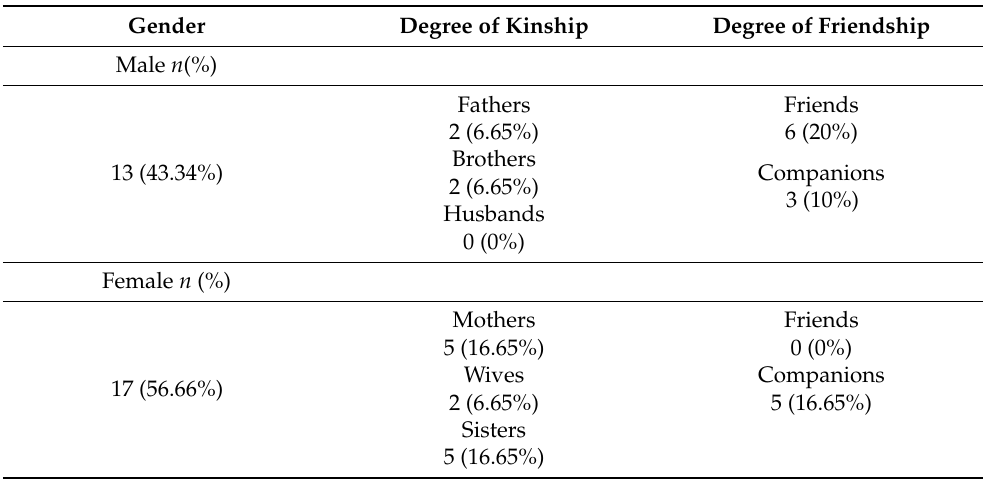
Table 2. Participants’